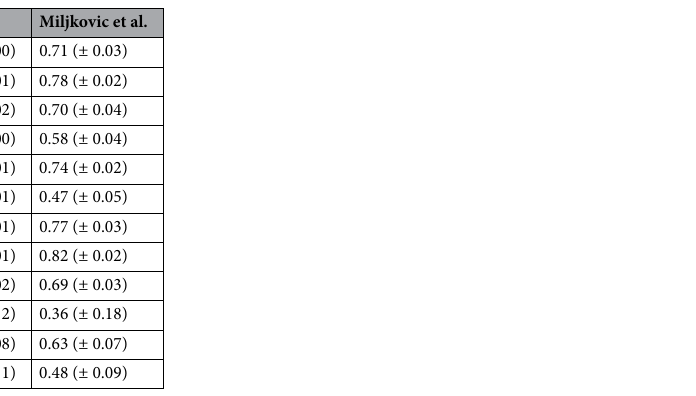
Table 6. Proposed models results compared to the results in Miljkovic et al. 8 for independent test sets in the 4 classification